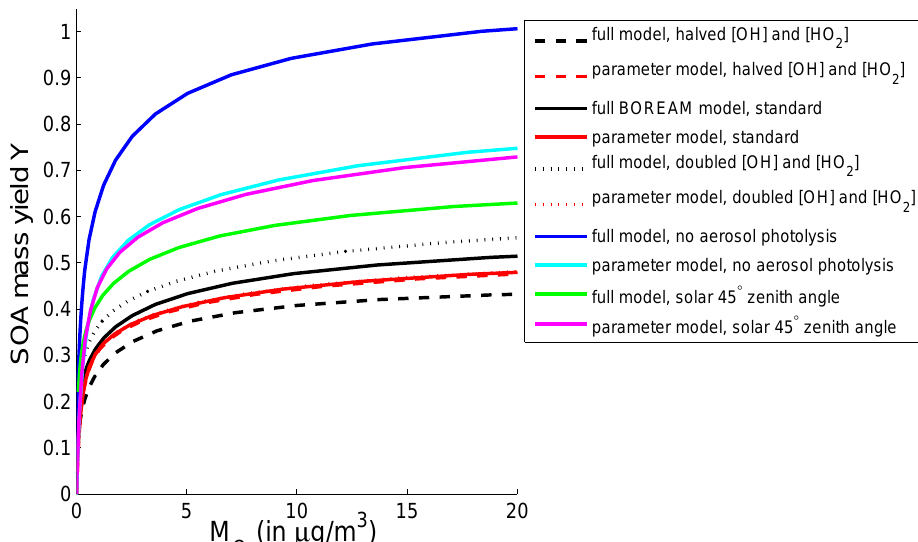
Fig. 8. Net SOA yields calculated for the OH-oxidation of α -pinene at low-NO x scenario, at 298K, for sensitivity tests with the full model and the parameter model for variations in OH and HO 2 concentrations, solar zenith angle and absence of particulate phase photolysis. These equilibrium SOA yields are obtained after 12 days into the photo-chemical ageing